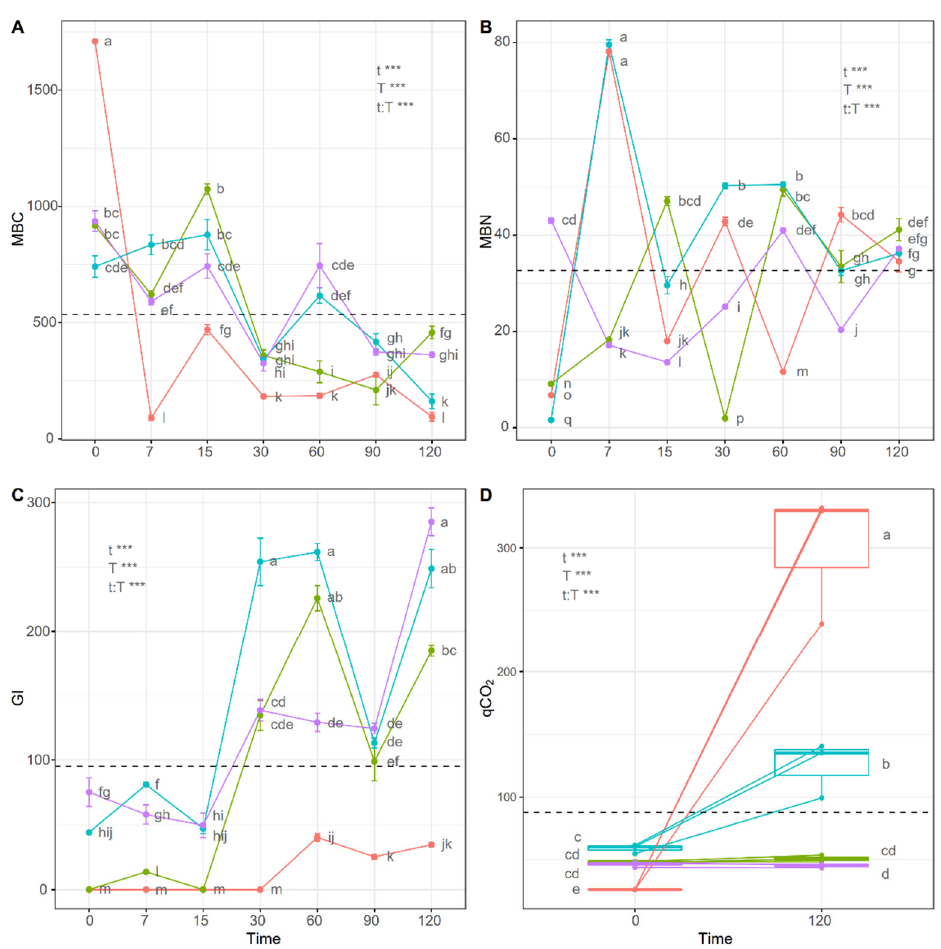
Figure 5. Two-way ANOVA for ecophysiological indicators of composting systems. Different letters indicate significant differences according to the two-way ANOVA with subsequent Tukey’s test of means at a significance level p ≤ 0.05. Vertical bars represent the standard deviation ( n = 5). ( A ) MBC, microbial biomass C (g C mic kg − 1 compost); ( B ) MBN, microbial biomass N (g N mic kg − 1 compost); ( C ) GI, germination index (%); ( D ) qCO 2 , metabolic quotient (g C-CO 2 kg − 1 compost). Dotted line represents the mean of the indicator; ***, highly significant ( p ≤ 0.001 )